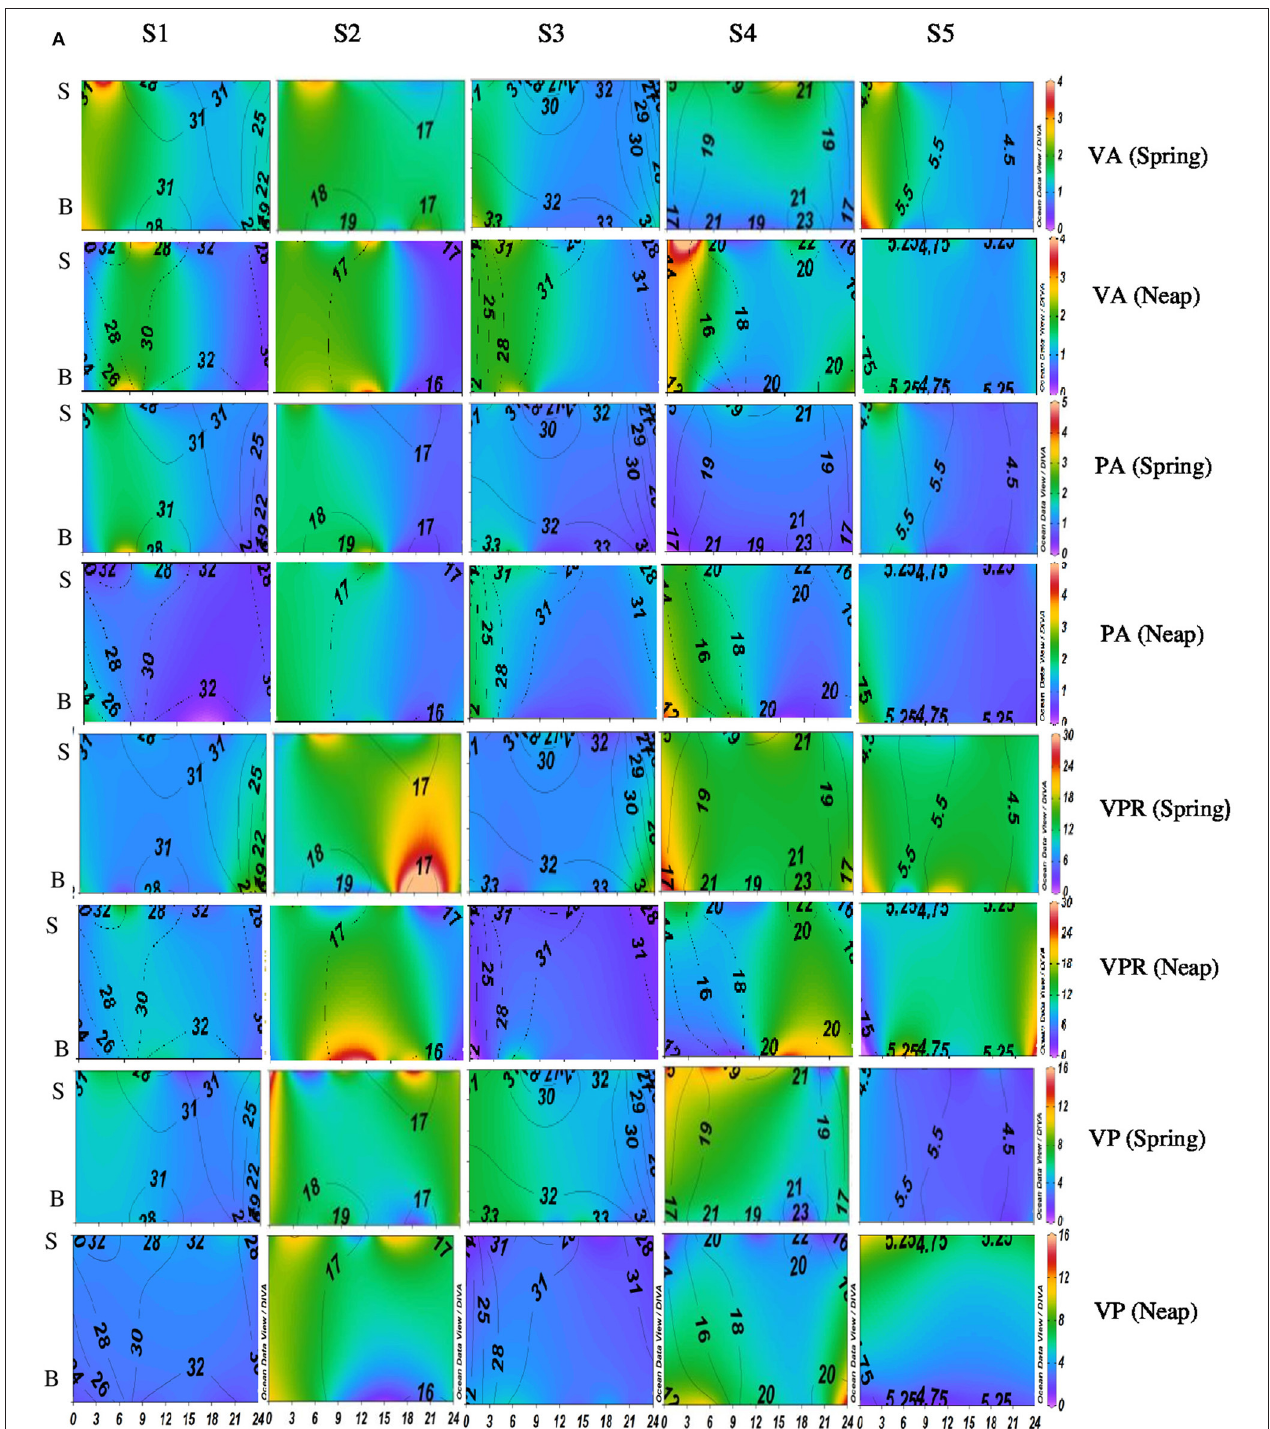
FIGURE 3A | Temporal variations (diel and tidal) in biological parameters during pre-monsoon (PRM) in CE. X- axis represents the time series observations from 00:00 to 24:00 h and Y-axis represent the vertical section of the water column (S, Surface; B, Bottom). Z-axis represent different parameters in color contours and salinity is superimposed as the line contours. The vertical panels S1, S2, S3, S4, and S5 represents the five stations. The horizontal panels represent various parameters during PRM, such as viral abundance (VA) (10 6 VLPs mL − 1 ), prokaryotic abundance (PA) (10 6 Cells mL − 1 ), virus-to-prokaryote ratio (VPR), and